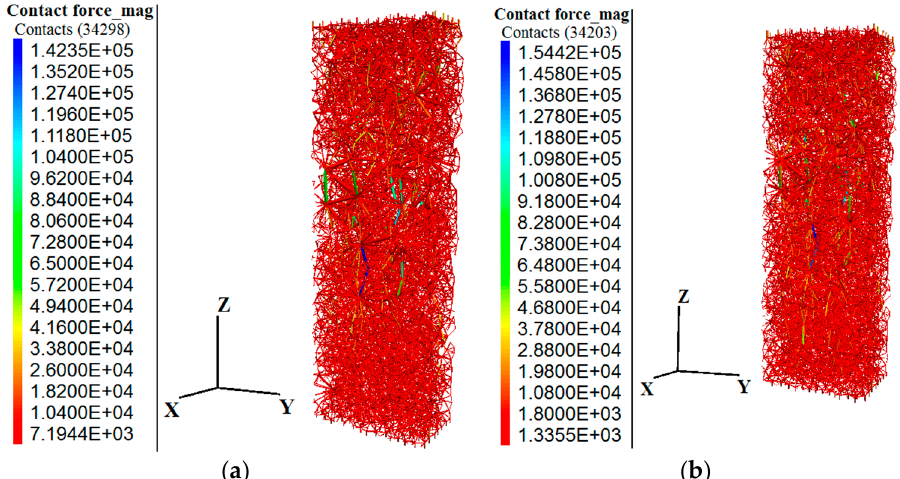
Figure 11. Contact force distribution of concrete during the second stage point (unit: N) with ( a ) 75 and ( b ) 150 cycles of freeze–thaw.